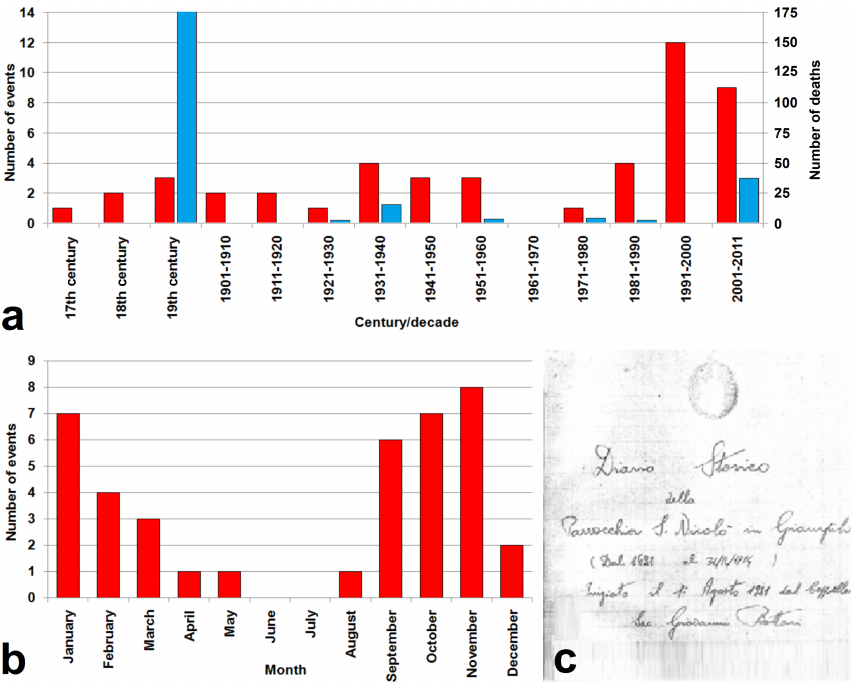
Figure 4. (a) Number of landslide/flood events (red bars) and related fatalities (blue bars) recorded in the southern Messina area per cen- tury/decade; (b) number of recorded landslide/flood events per month of occurrence; (c) frontispiece of the historical diary of S. Nicolò di Giampilieri church.